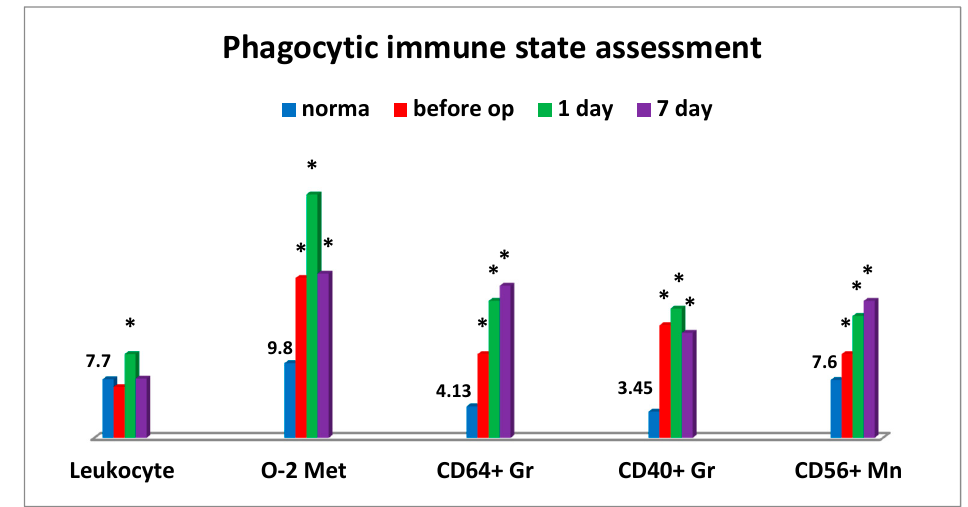
Figure 1. Evaluation of phagocytic immune unit. Legend: O-2 Met = oxygenic metabolism; conditional unit/1000 Nph = neutrophils; % Gr = granulocytes; Mn = monocytes; Leukocyte = billion/L; op = operation; * significance of differences between groups in all figures are reliable when P < 0.01 or P < 0.001.